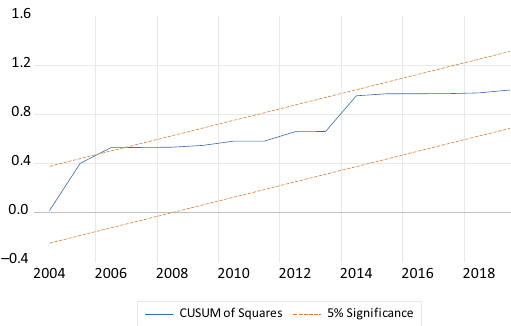
Figure 2. Cusum squares